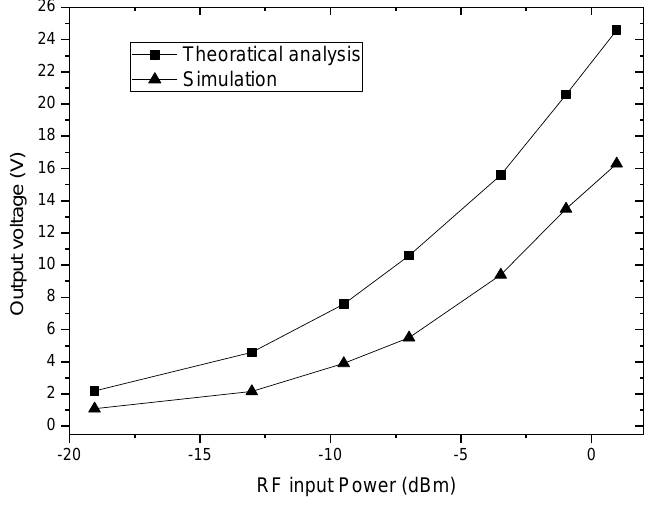
Figure 13. Comparison of the output voltage of the theoretical analysis and simulation results.